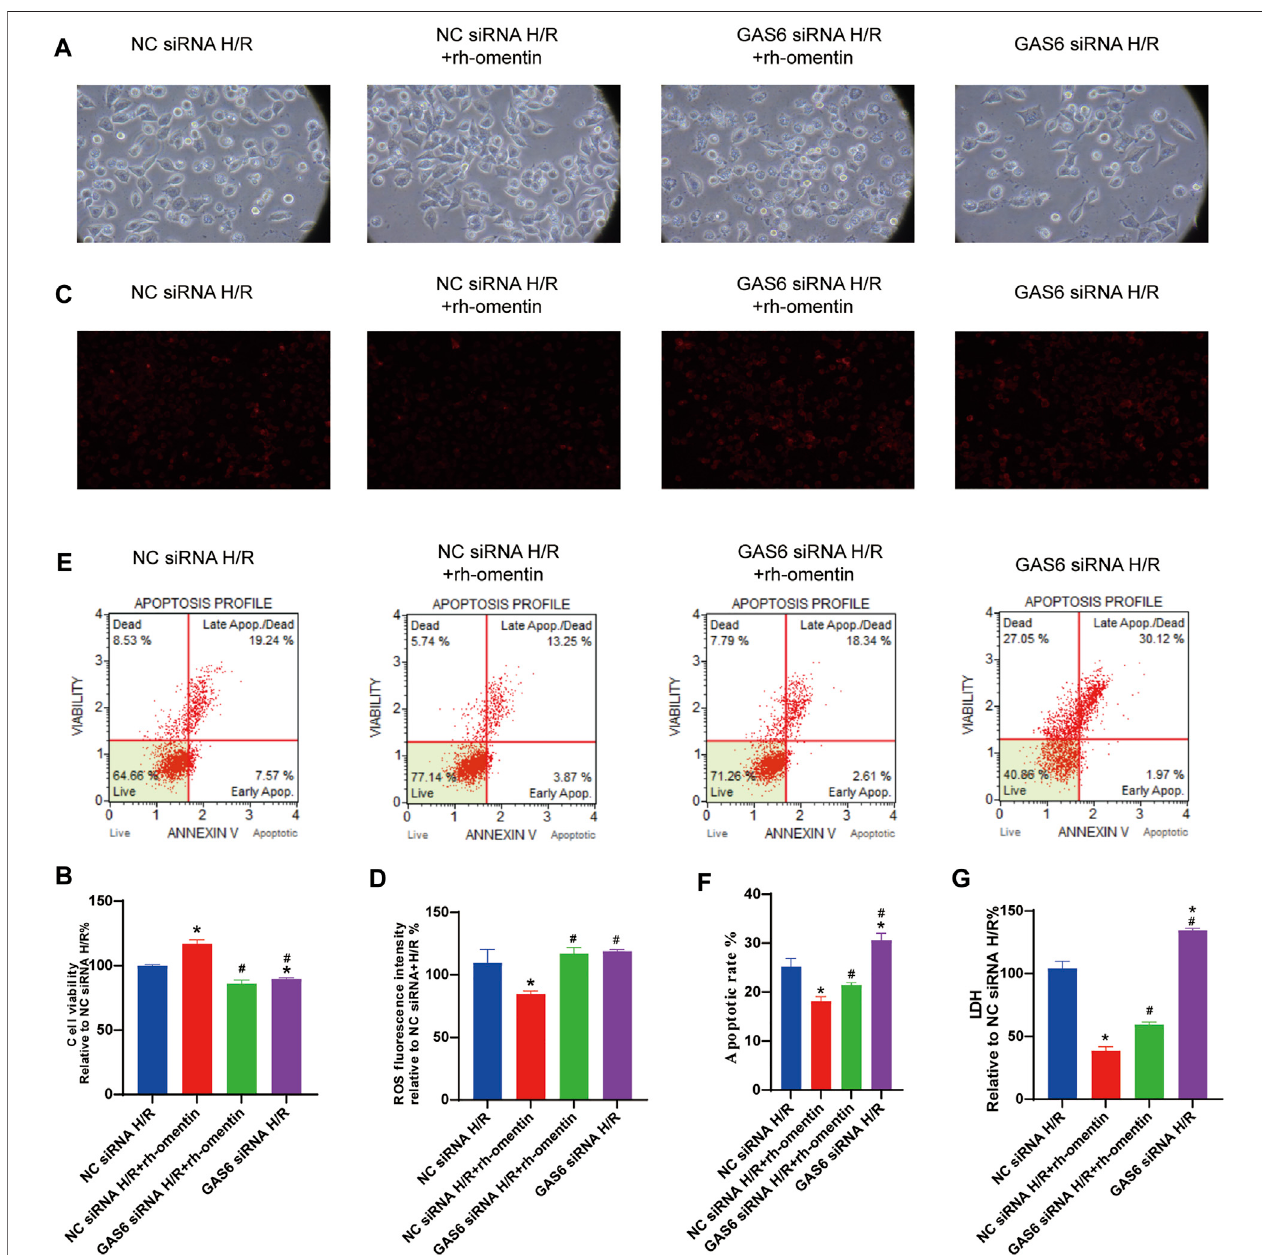
FIGURE6| EffectofGAS6siRNAsandrh-omentinonthecellviability,ROSgeneration,cellularapoptosis,andLDHreleaseinN2acellsinjuredbyH/R. (A) N2acells wastransfectedwithsiRNAtargetingGAS6oranegativecontrolsiRNA(NC)for24 h,exposedto750 ng/mlrh-omentinfor3 h,andthenexposedtoH/Rinjury,followed by detection of cell viability. (B) Statistical graph of cell viability. (C) Intracellular ROS levels of H/R-induced injury in N2a cells. (D) Statistical graph of intracellular ROS levels. (E) ApoptoticanalysisofH/R-inducedinjuryinN2acells. (F) Statisticalgraphofapoptoticrates. (G) LDHreleaseofH/R-inducedinjuryinN2acells.Errorbars showthestandarddeviationfor n (cid:2) 6measurementsfromrepresentativeexperiments.* p < 0.05 vs. theNCsiRNA+H/R; # p < 0.05 vs. theNCsiRNA+rh-omentin+ H/R group.